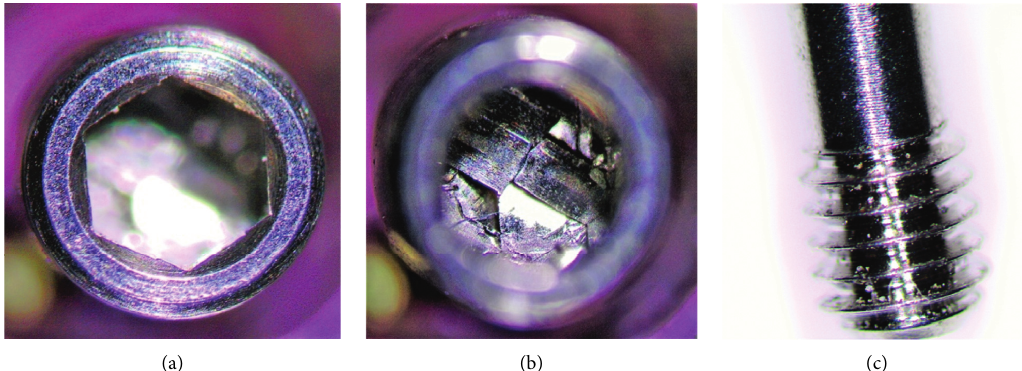
Figure 8: Iconekt ® screw magnification analysis: (a) screw head, (b) inside screw connection, and (c) screw thread